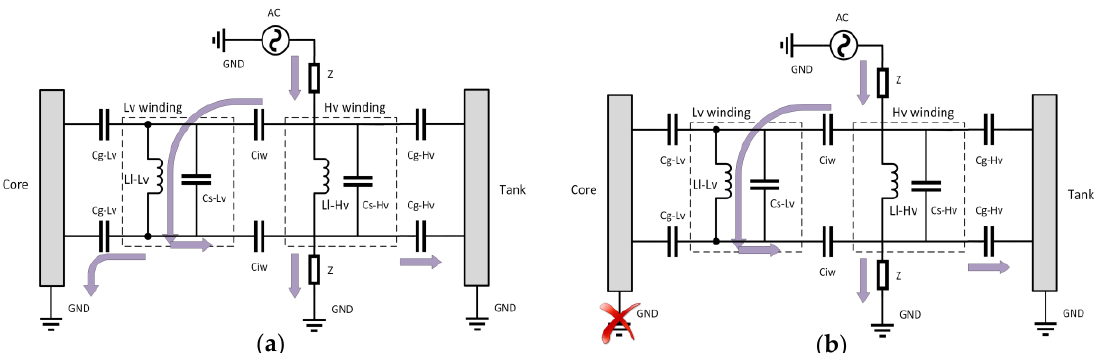
Figure 25. Equivalent circuit of a two-winding transformer; ( a ) grounded core, ( b ) core ground loss.